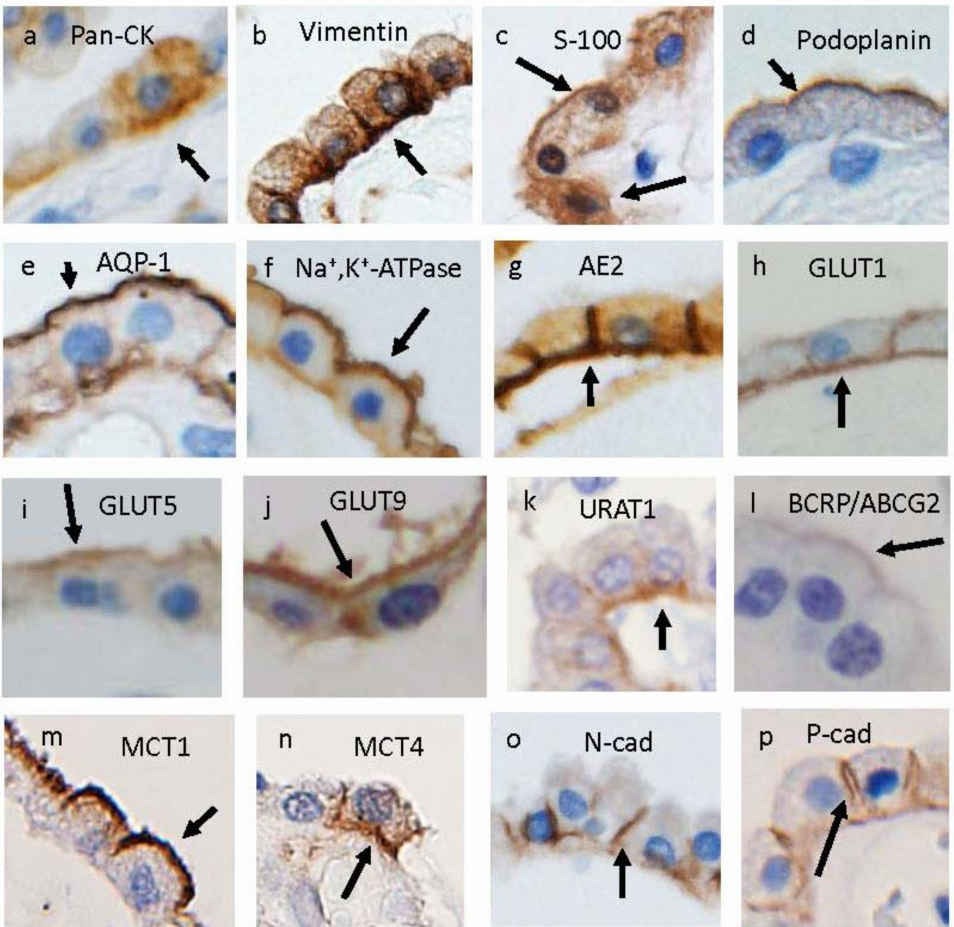
Figure 2. Localization of representative cytoplasmic membrane ( a – d ); anion/cation transporters ( e – g ); transporters for glucose ( h ), fructose ( i ), urate ( j – l ), and lactate ( m , n ); and junctional components ( o , p ) in autopsied human brains. Immunoreactivities for pan-cytokeratins (pan-CK) ( a : DAKO, M3515); vimentin ( b : DAKO, M0725); S-100 ( c : Nichirei, 422091); podoplanin ( d : DAKO, M3619); AQP-1 ( e : ProteinTech, 20333-1-A); Na + ,K + -ATPase ( f : Santa Cruz, sc-48345); anion exchanger 2 (AE2) ( g : SantaCruz, sc-376632); transporters for glucose (GLUT1) ( h : Abcam, ab150299), fructose (GLUT5) ( i : IBL, 18905), urate (GLUT9) ( j : Abcam, ab104623), urate (URAT1) ( k : MBL, BMP064), urate (BCRP/ABCG2) ( l : Abcam, ab3380), lactate (MCT1) ( m : Merck, AB3538P), and lactate (MCT4) ( n : Abcam, ab244385); N-cadherin ( o : ProteinTech, 22018-1-AP); and P-cadherin ( p : Santa Cruz, sc-74545) are observed in the cytoplasm of luminal or basolateral cytoplasmic membrane of CPE